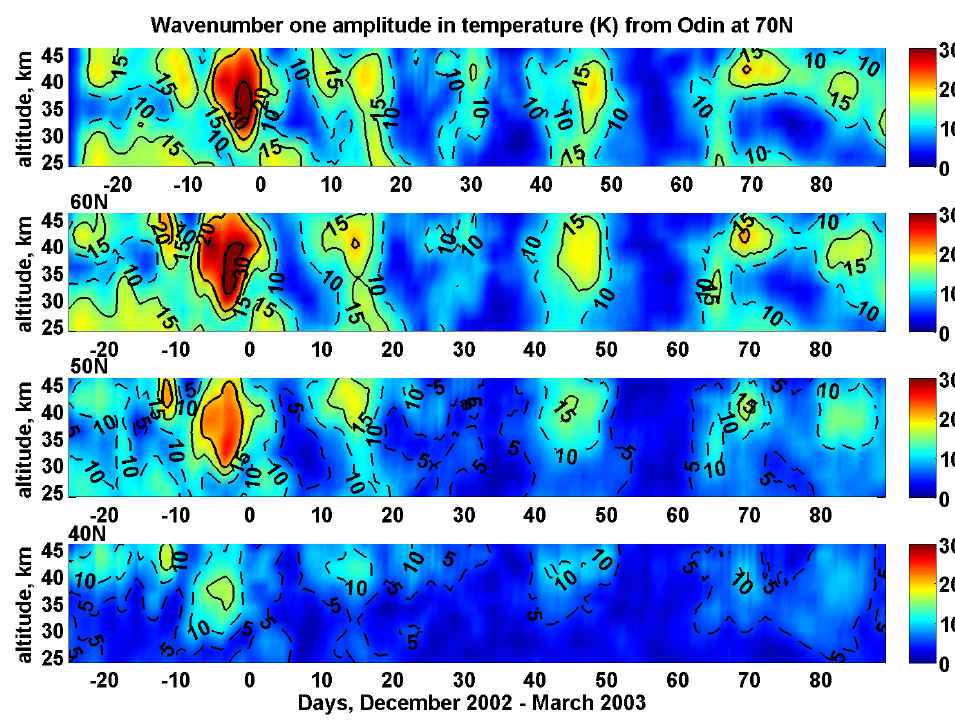
Fig. 4. Wavenumber one amplitude in temperature (K) from Odin SMR data at 70 ◦ N, 60 ◦ N, 50 ◦ N, 40 ◦ N.